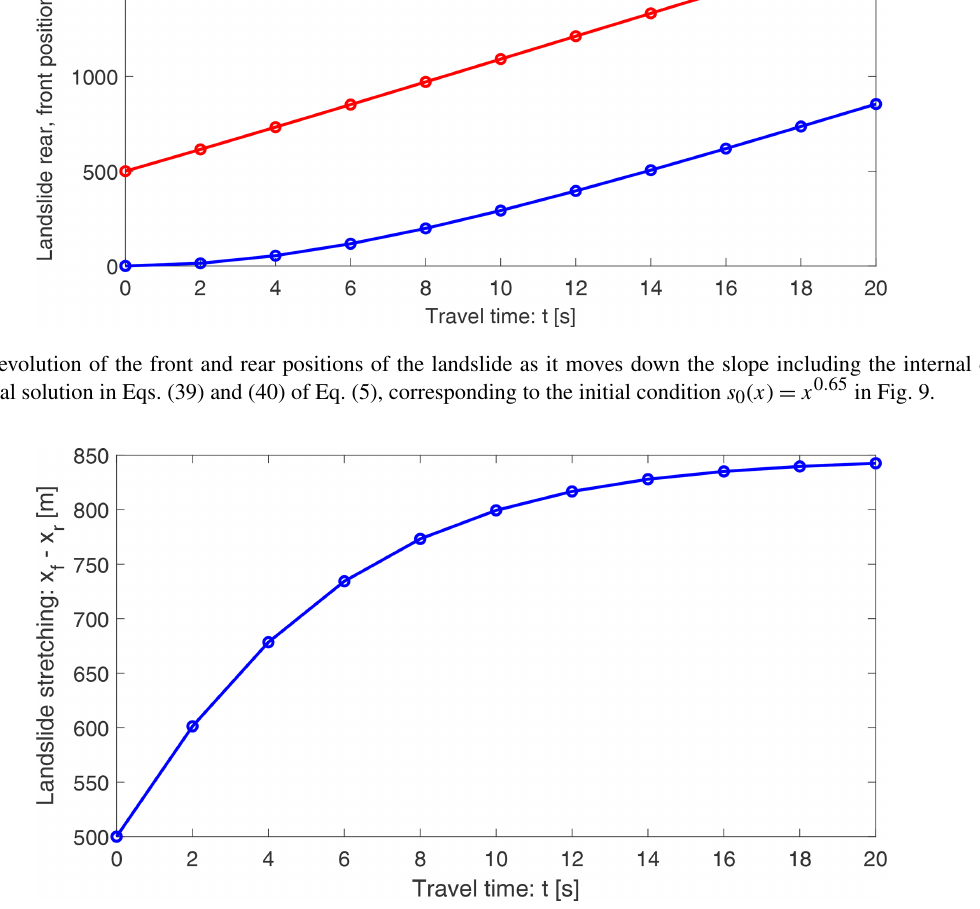
Figure 11. Time stretching of the landslide down the slope including the internal deformation given by the general solution in Eqs. (39) and (40) of Eq. (5), corresponding to the initial condition s 0 ( x ) = x 0 . 65 in Fig.